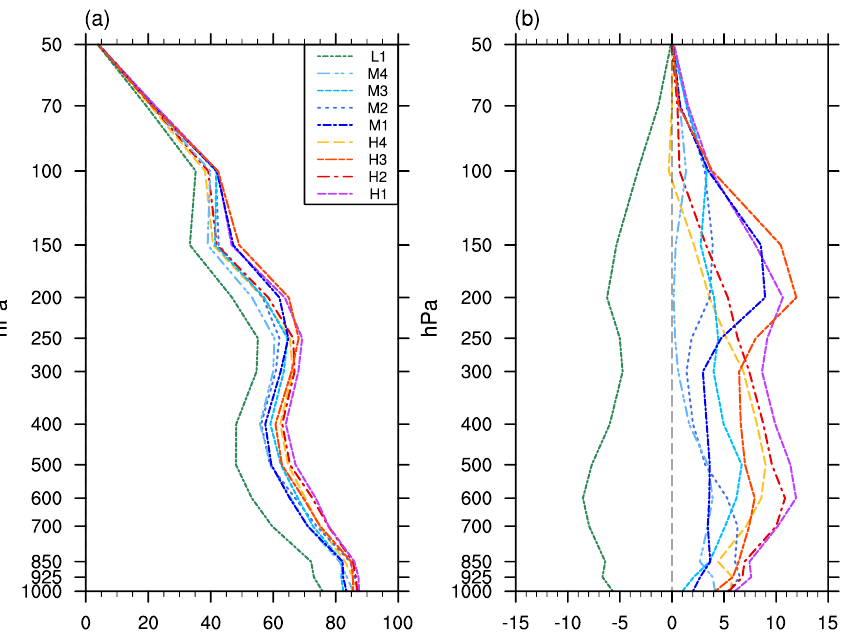
Figure 16. Composite means of vertical profiles of area-averaged relative humidity ( a ) and relative humidity anomalies ( b ) over South China for the nine regimes during AMJ 1979–2015. The units for both relative humidity and relative humidity anomalies are